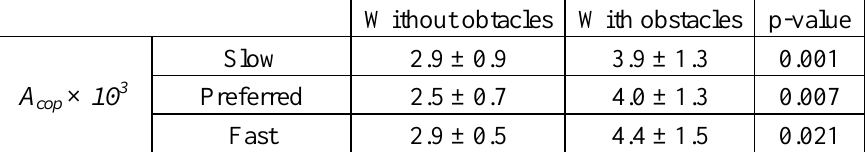
) in mm 2 and cop